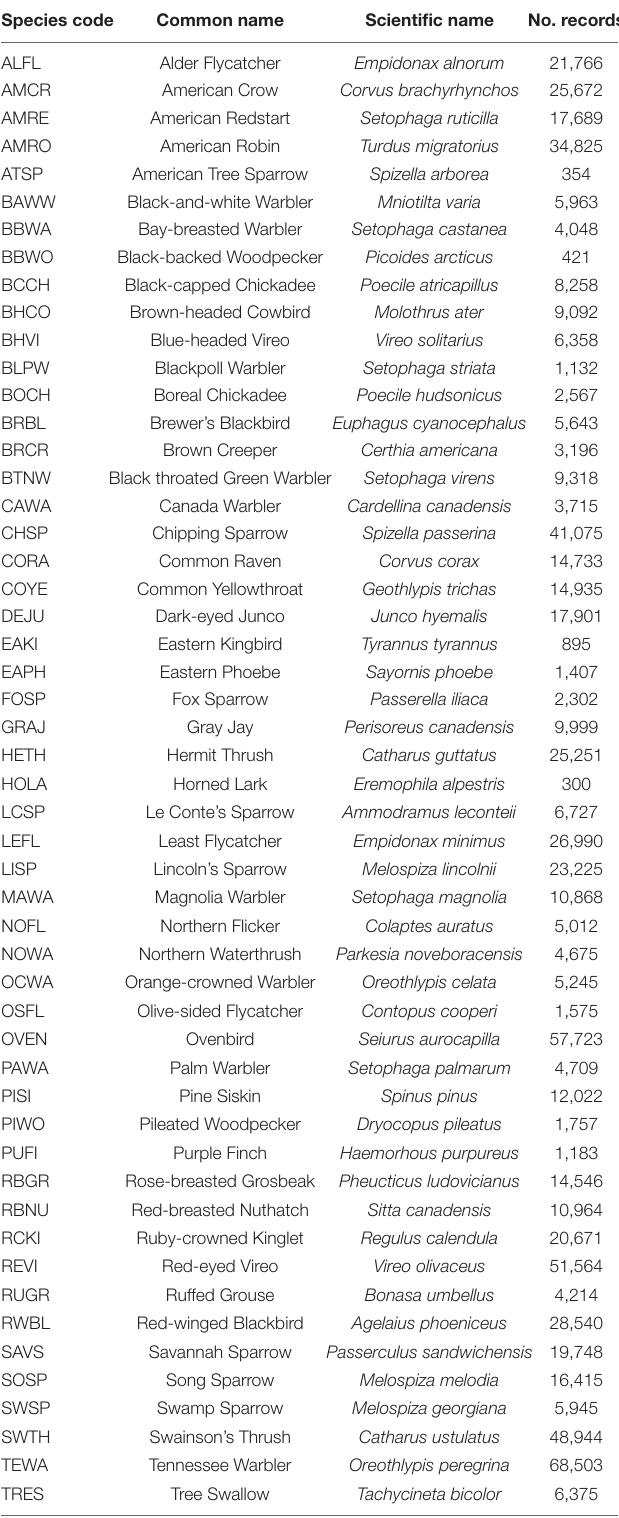
TABLE 1 | Landbird species code, common and scientific names, and the number of records (number of individuals detected in point count surveys) per species in the dataset used to build the landbird statistical